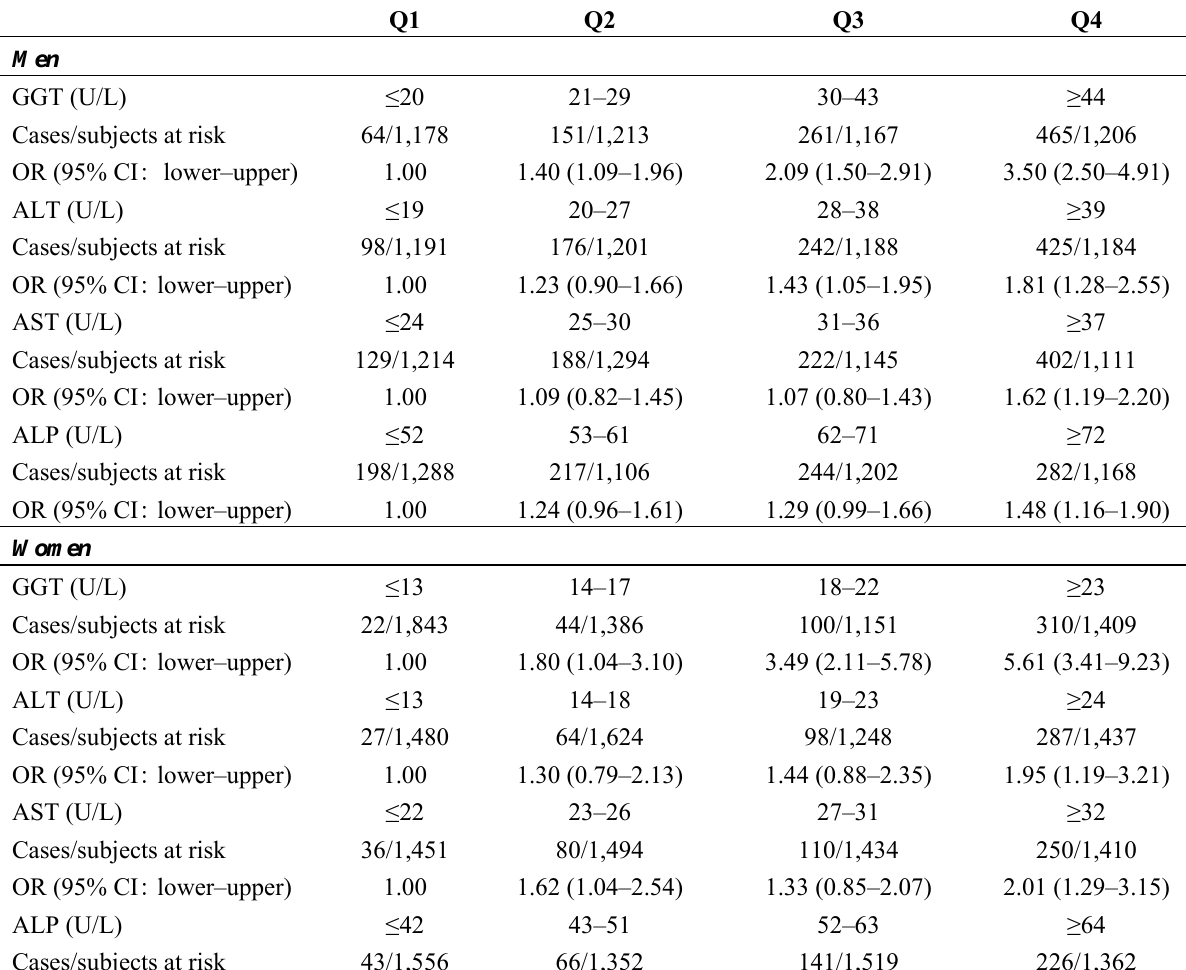
Table 3. Factors associated with MetS by